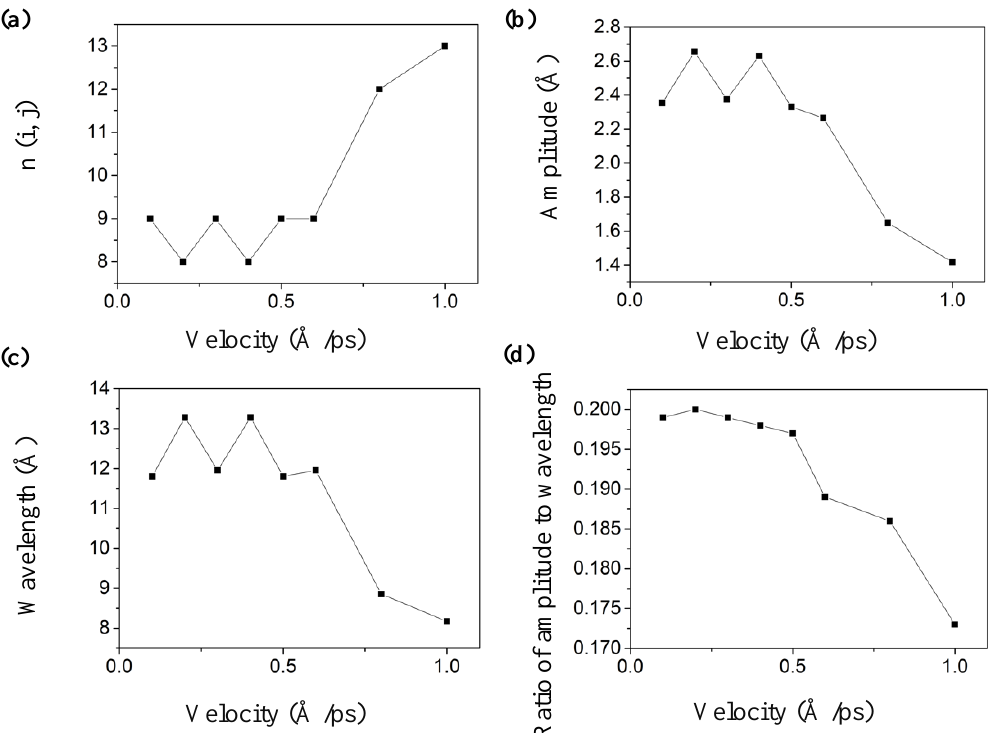
Figure 4. The relationship between the velocity and wrinkling parameters: ( a ) Wrinkling number, ( b ) Amplitude, ( c ) Wavelength, ( d ) Ratio of amplitude to wavelength.